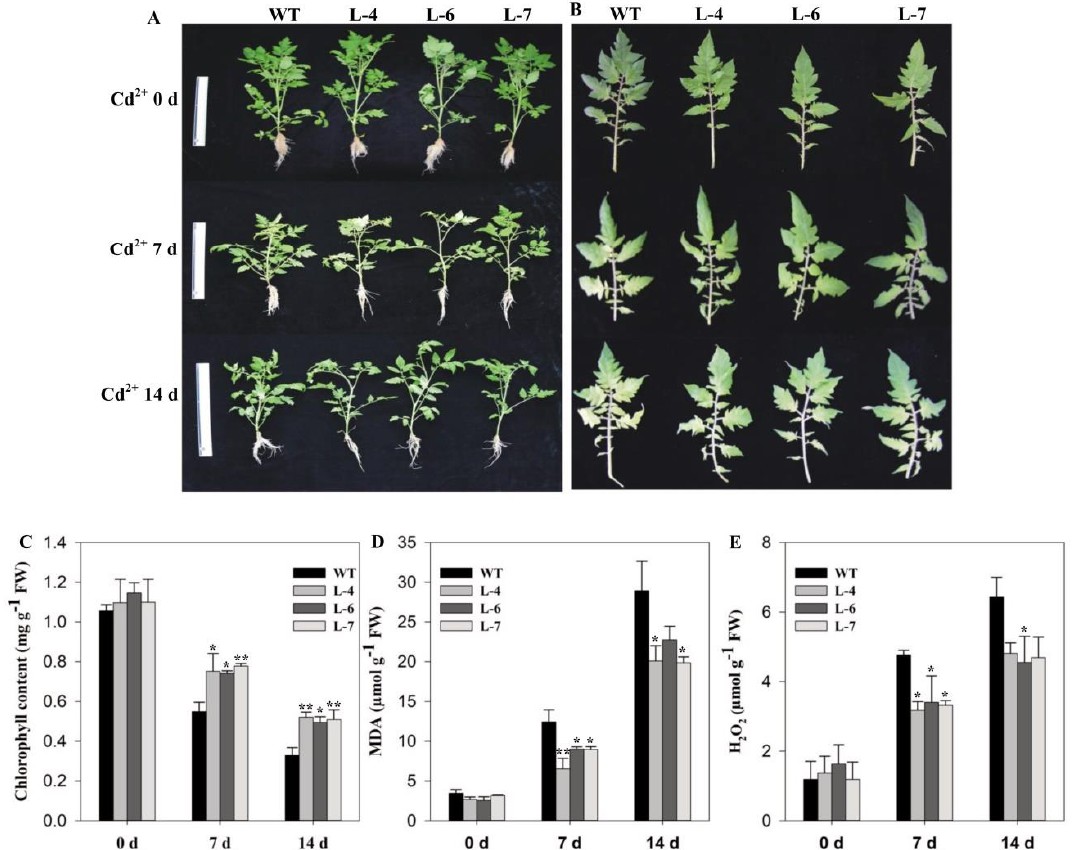
Figure 4. Overexpression of SlMAPK3 enhanced cadmium tolerance in tomato. ( A ) Plant phenotypes. ( B ) Images of the second leaves of WT and SlMAPK3 overexpressed lines ( C ) chlorophyll content, ( D ) malondialdehyde (MDA) content, and ( E ) H 2 O 2 accumulation. Seedlings of WT and transgenic lines at five leaf-stage were treated with 0 (0 days) and 100 µM (7- and 14-days) cadmium. For C – E , data represent mean ± SE of three biological replicates. **, * significant level differed at p < 0.01 and p < 0.05, respectively.